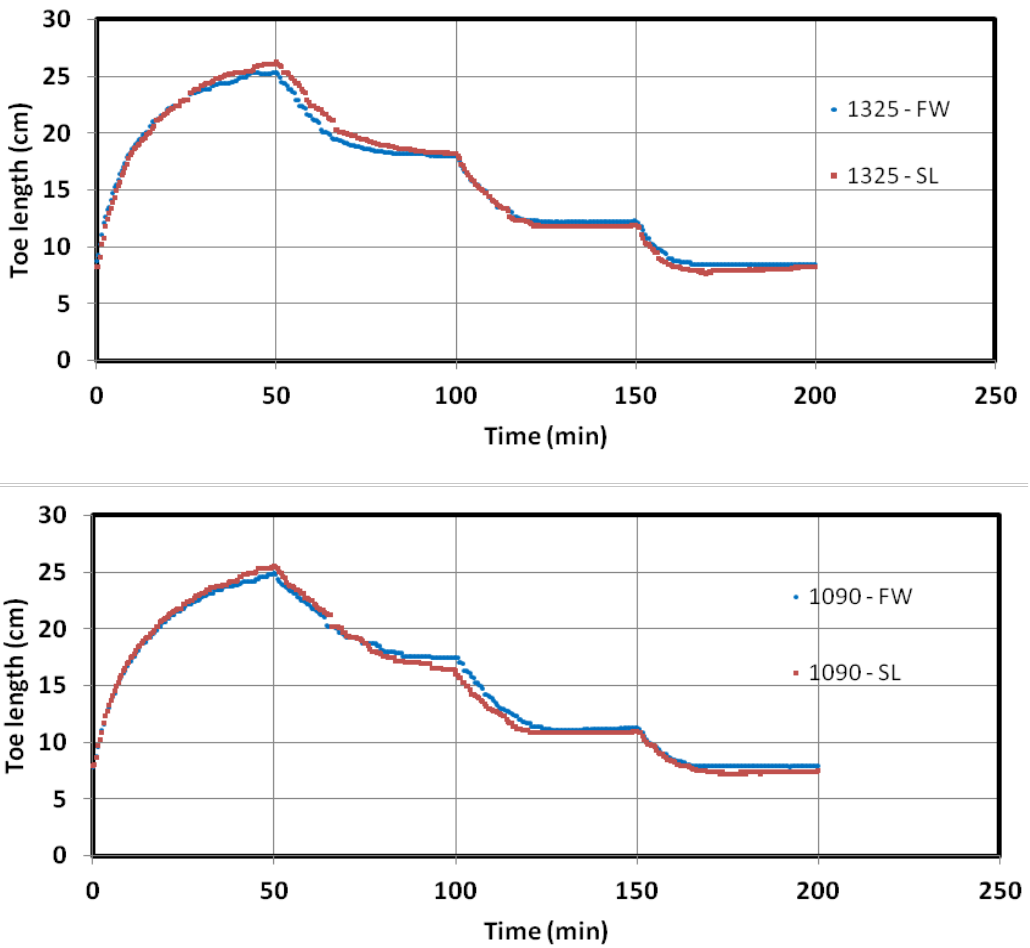
Figure 5. Transient experimental toe length data in a receding scenario in case 1325 ( top ) and case 1090 ( bottom ) for both FW and SL scenarios